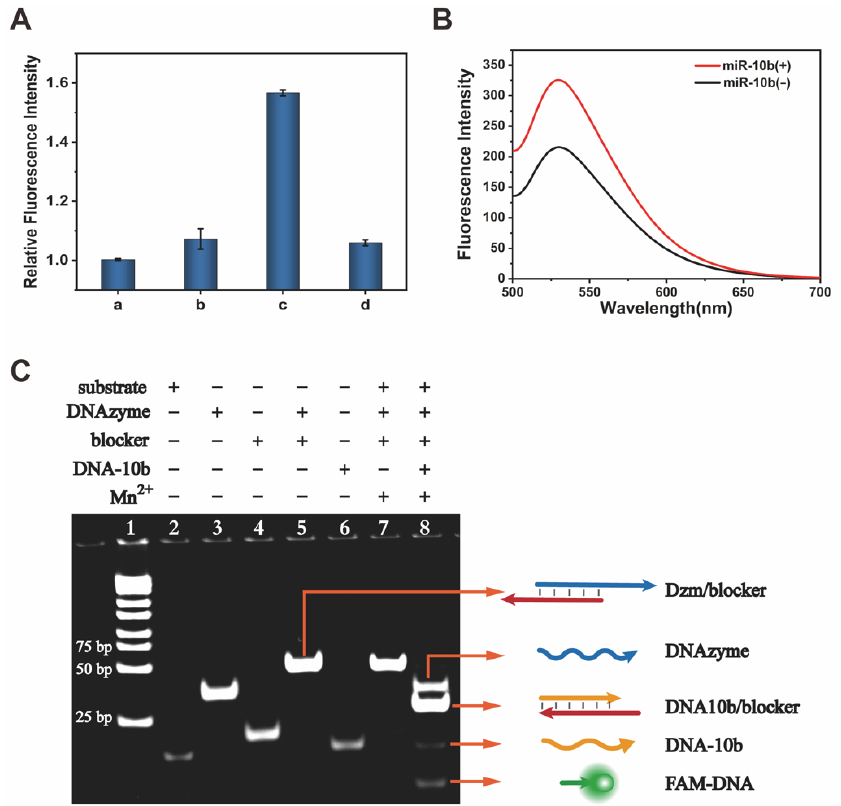
Figure 1. The feasibility of the detection of miR-10b with the DNAzyme amplification strategy. ( A ) The relative fluorescence intensity of the solution under different conditions: (a) substrate; (b) sub- strate + DNAzyme; (c) substrate + DNAzyme + Mn 2+ ; (d) substrate + Dzm/blocker + Mn 2+ . Error bars represent the standard deviation of three determinations. ( B ) The fluorescence emission spectra of the DNAzyme amplifier in the absence and presence of miR-10b. Experimental conditions: miR-10b concentration of 50 nM, substrate concentration of 25 nM, DNAzyme concentration of 25 nM, blocker concentration of 30 nM, Mn 2+ concentration of 750 μM , 25 mM Tris-HCl buffer (containing 137 mM NaCl, pH 7.0). ( C ) Polypropylene gel electrophoresis, lane 1: DNA marker (25 – 500 bp); lane